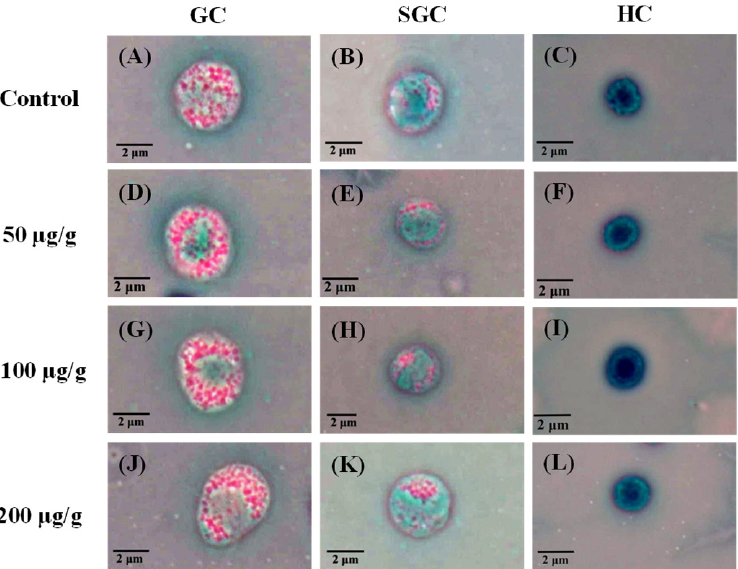
Figure 1. Phase-contrast micrograph of white shrimp that received the PNWE at 50, 100, and 200 μ g (g shrimp) − 1 and control shrimp. ( A – C ) control at 240 h; ( D – F ) injection 50 μ g (g shrimp) − 1 PNWE at 240 h; ( G – I ) injection 100 μ g (g shrimp) − 1 PNWE at 240 h; ( J – L ) injection 200 μ g (g shrimp) − 1 PNWE at 240 h. (1000 × ). PNWE: Panax notoginseng water extract. GC: granular haemocyte. SGC: semi granular haemocyte. HC: hialin haemocyte.